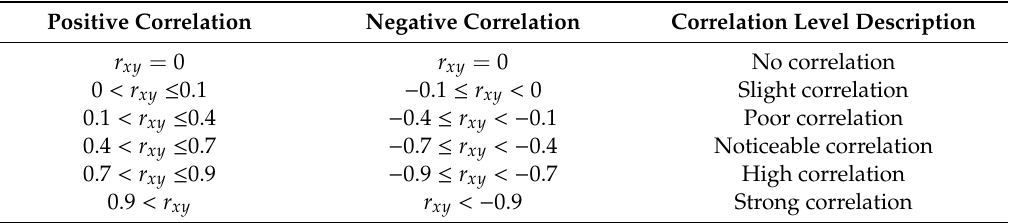
Table 4. Correlation level description